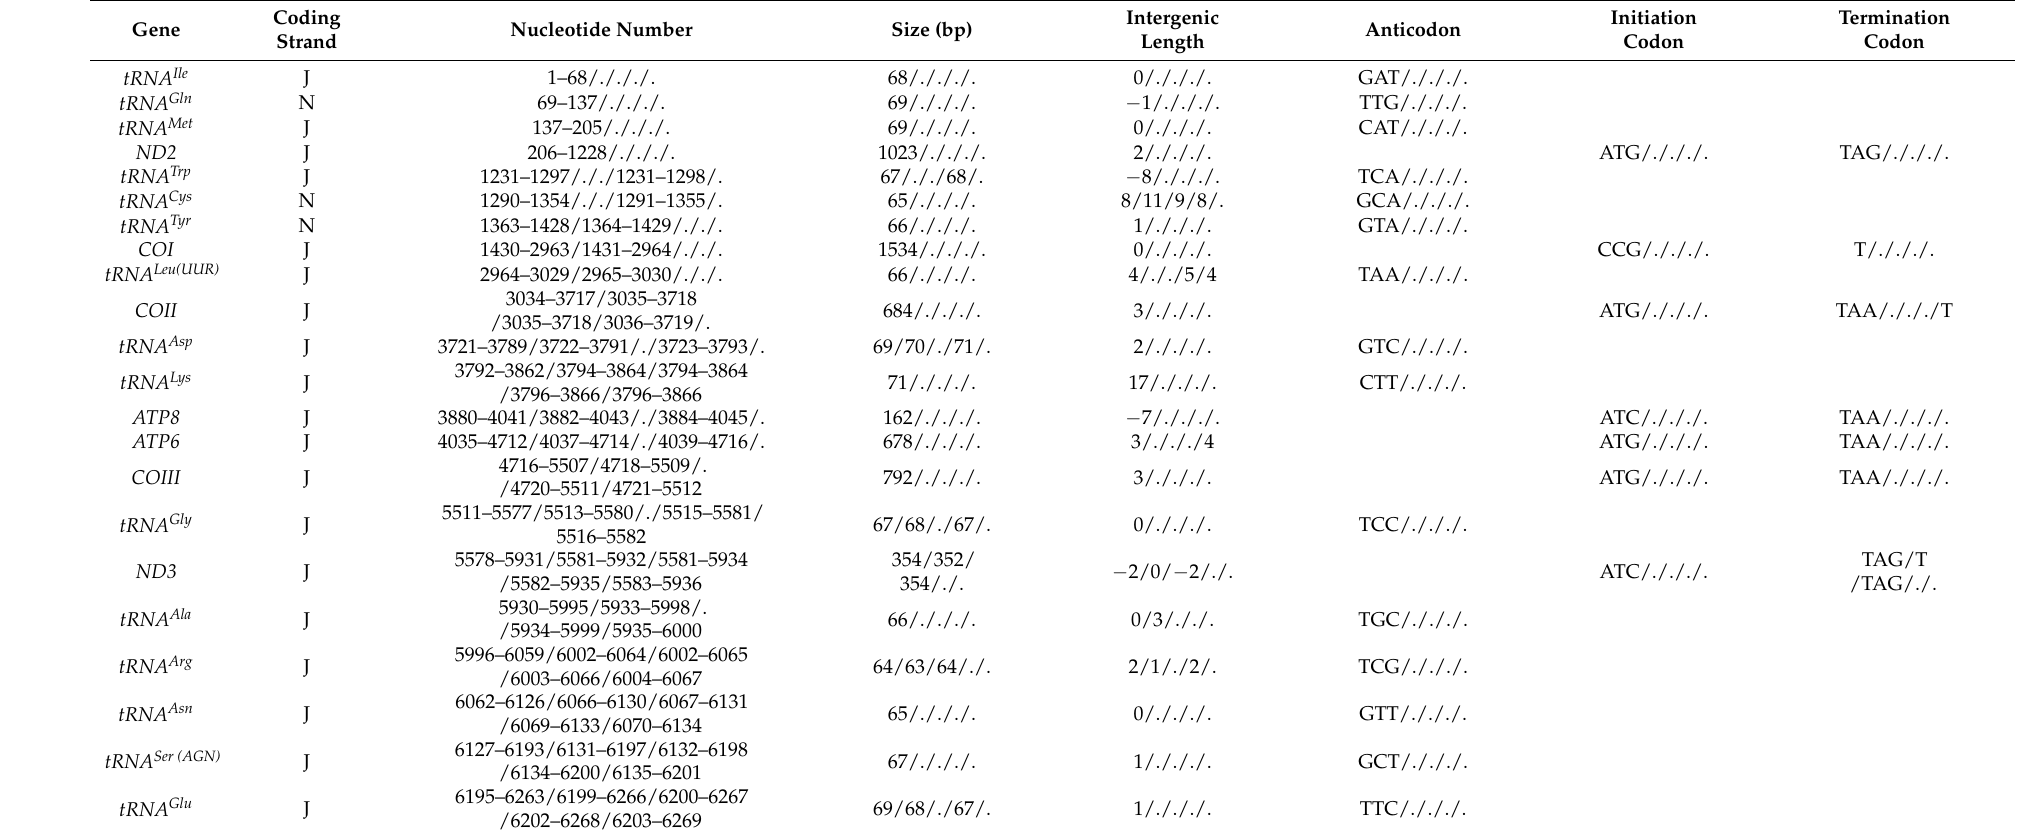
Table 3. Annotations for the five species grasshopper